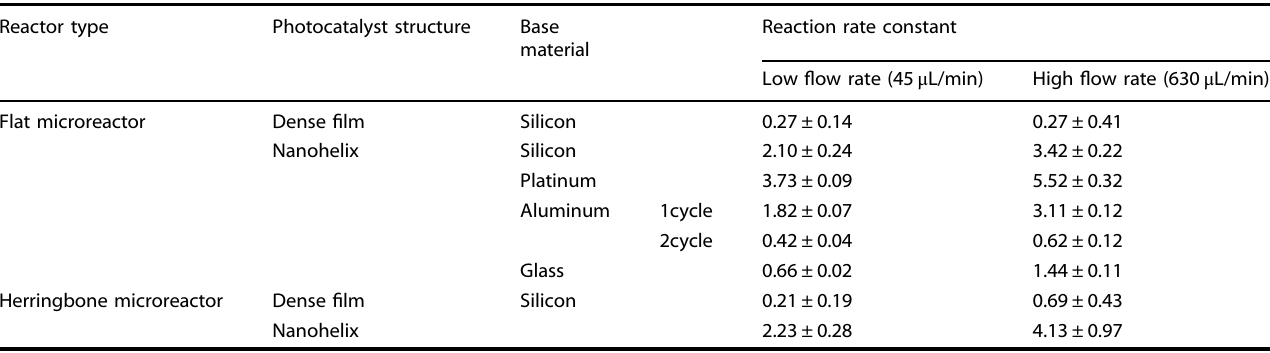
Table 1. Reaction rate constants for various types of microreactors at low and high fl ow rates.